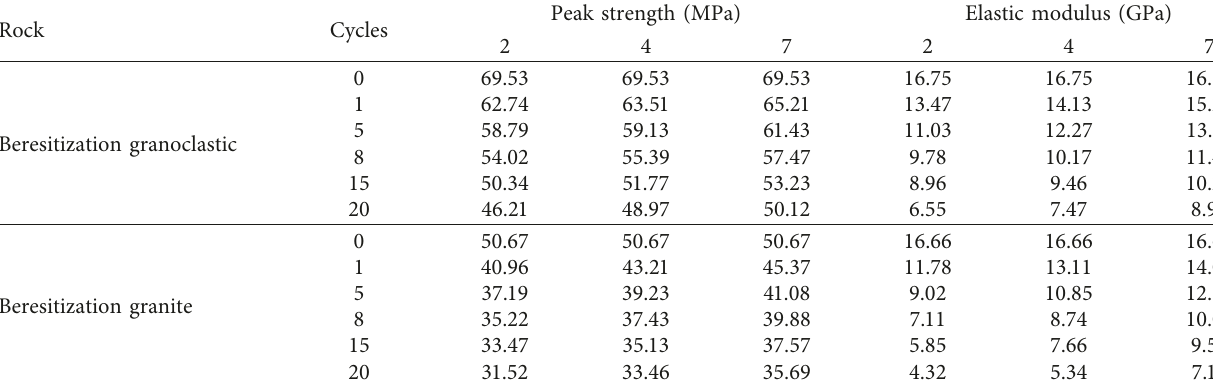
Figure 7: The fitting relationship between mechanics parameters and cycles. (a) Beresitization granoclastic. (b) Beresitization granite. Table 3: Uniaxial compression test of the altered